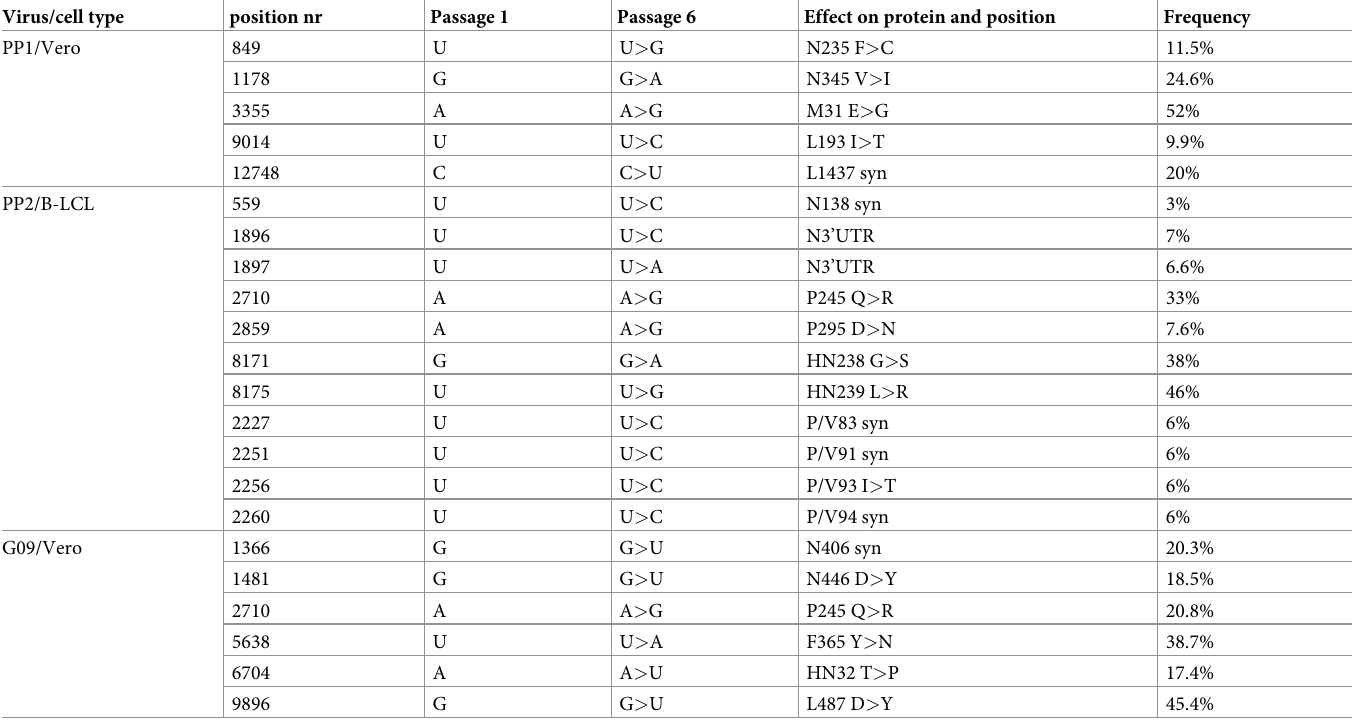
Table 3. Examples of novel mutations observed after 6 passages of PP1, PP2 and the parent MuV G09 virus. Virus/cell type